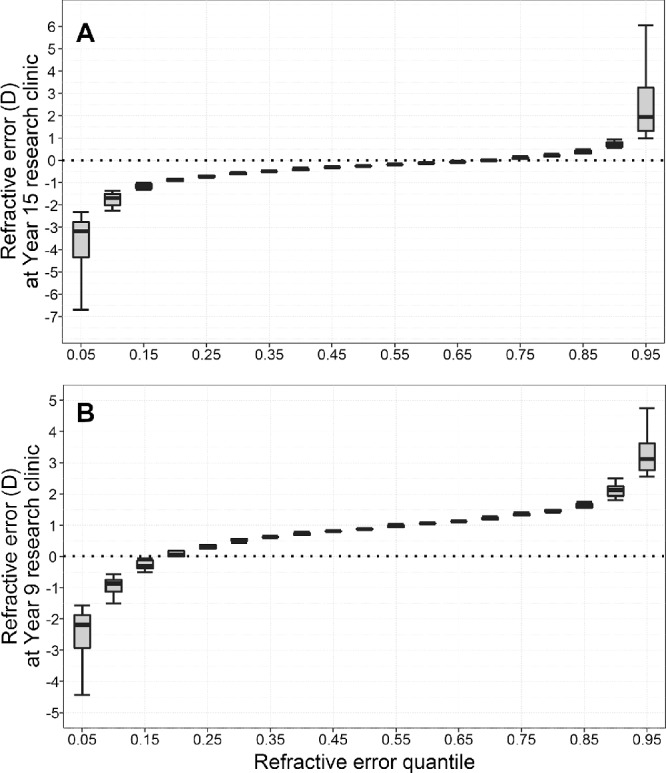
Distribution of refractive error by quantiles. (A) refractive error at the age 15 research clinic in ALSPAC participants. (B) Refractive error at the age 9 research clinic in Generation R participants. Participants in each study sample were ranked by refractive error (most myopic to most hyperopic) and then divided into 19 equally sized bins (quantiles).